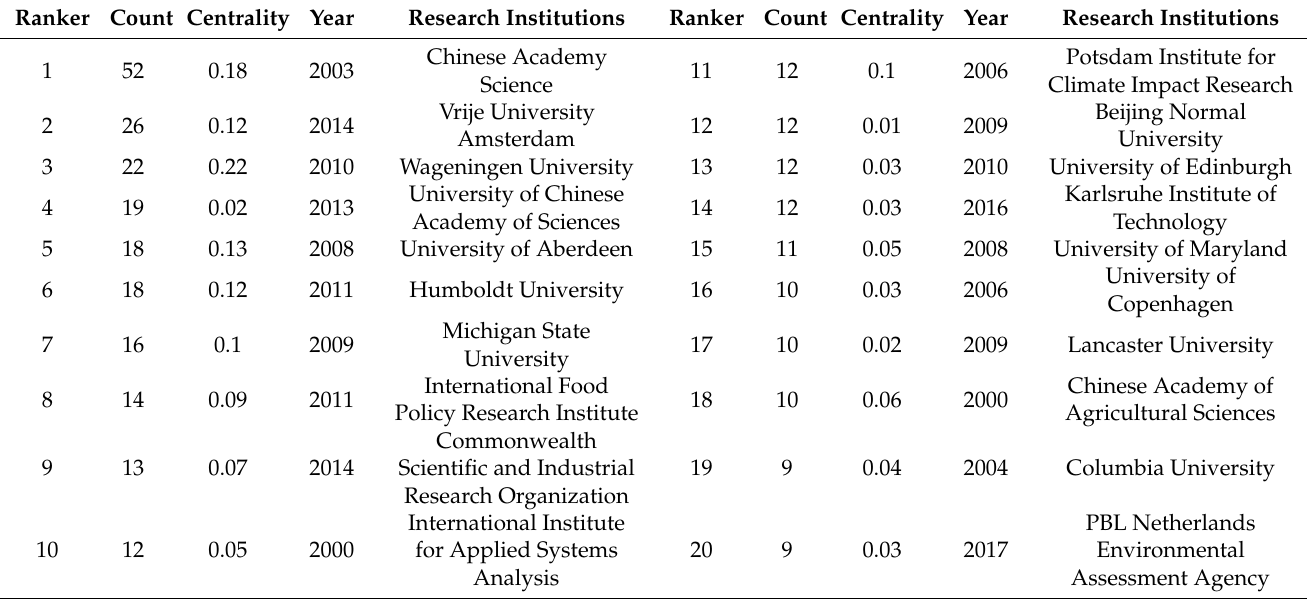
Figure 3. Institutional cooperation network map. Table 2. Information table of the top 20 major research institutions with published articles.